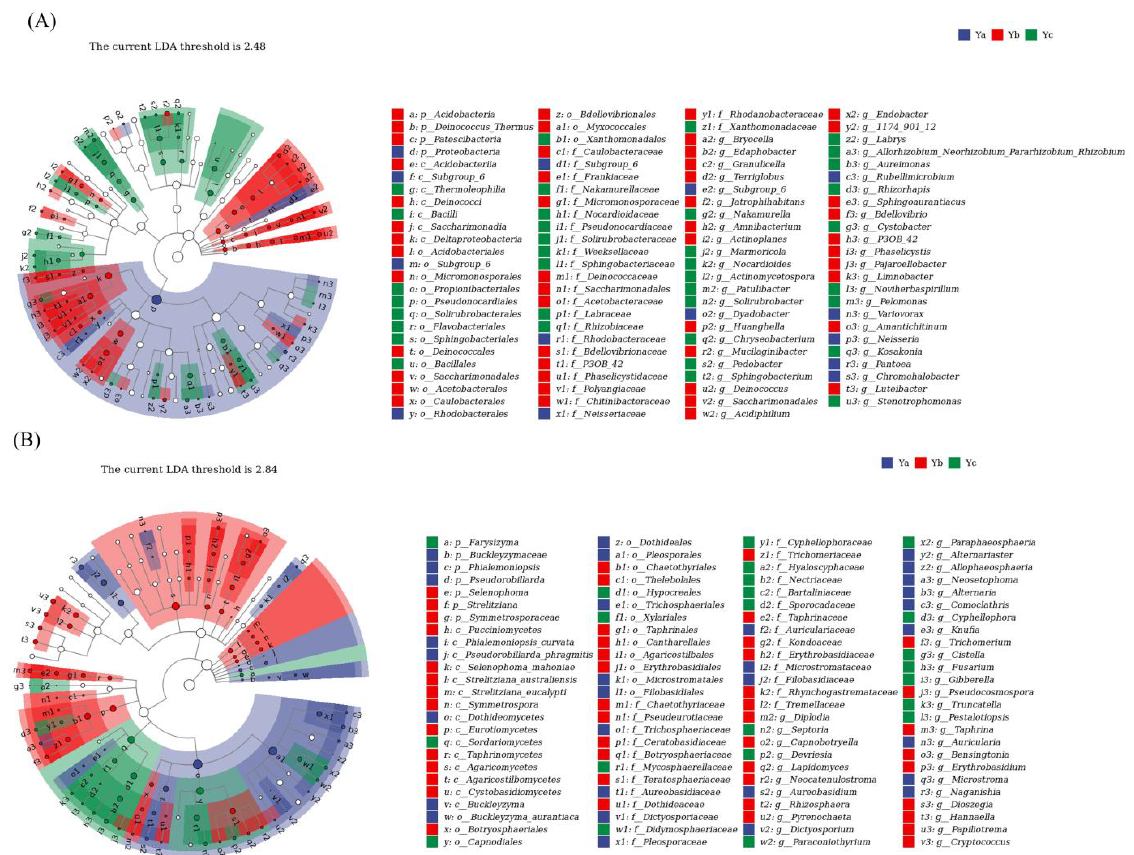
Figure 5. An LEfSe (LDA effect size) linear discriminant analysis was used to identify the biomarkers with significant differences among Ya, Yb, and Yc. From phylum to genus (from inner circle to outer circle), the taxonomic branching illustrates the taxonomic hierarchies of the main taxa in the sample community. The sizes of the nodes correspond to each taxon’s average relative abundance. Nodes with different colors (green and red) indicate that those taxa exhibited significant intergroup differences and were more prevalent in the group samples represented by those colors. Hollow nodes represent taxa that did not differ significantly between groups. Letters identify the names of taxa